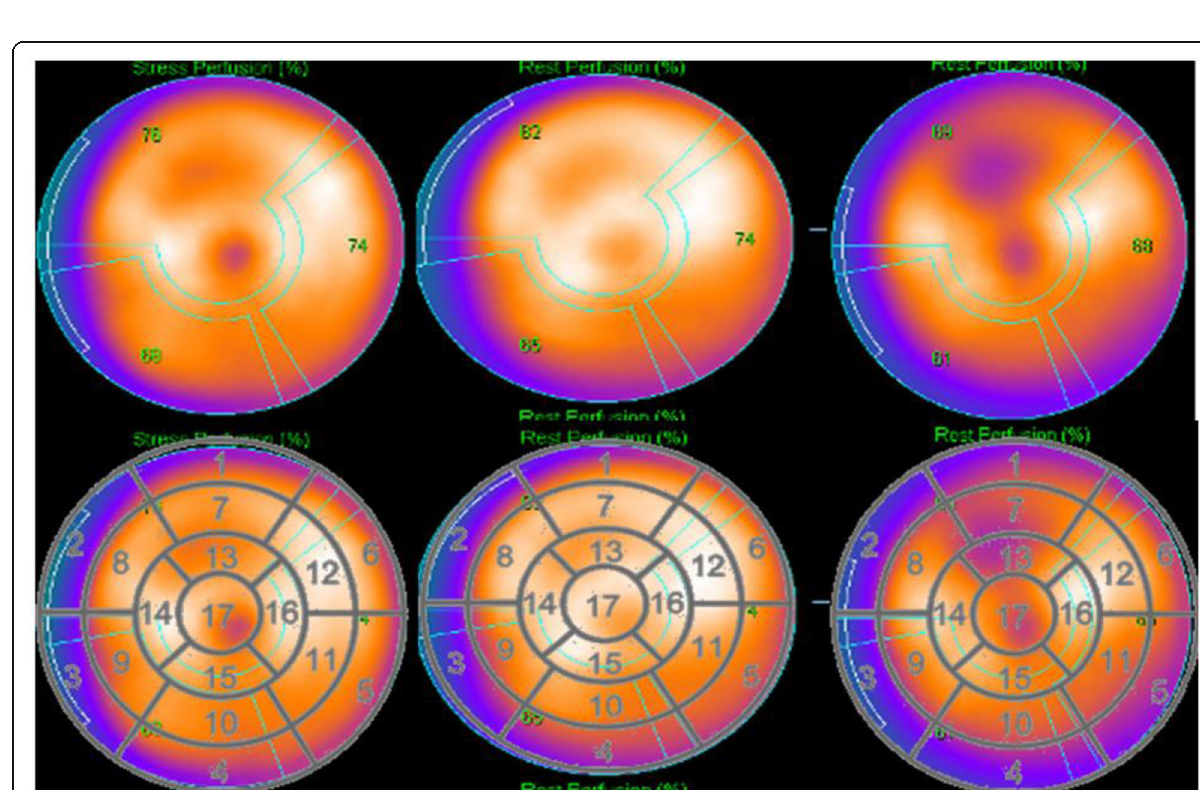
Fig. 7 Polar map in stress, early rest, and delayed rest of MPS of 65-year-old female patient presented with dyspnea, diabetic but not hypertensive classified clinically to be low risk. Her perfusion scan demonstrated mild small ischemia in the apex in the stress study with complete recovery in the rest phase. SSS = 3, SRS = 1, and SDS 2. EF was 62%. Her GWR was